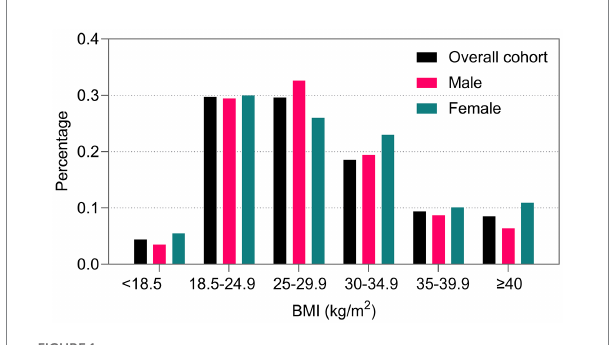
FIGURE 1 Distribution of BMI categories among men and